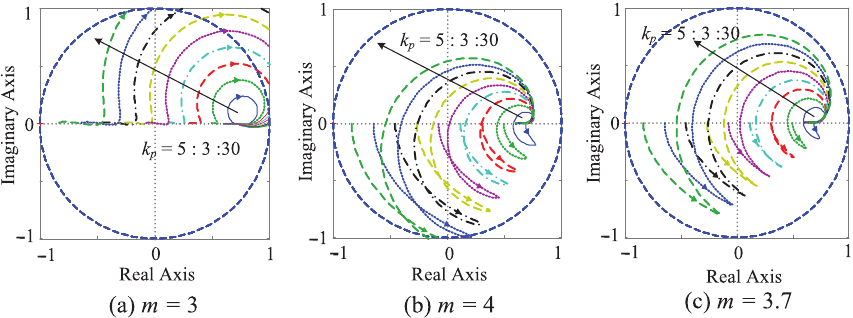
Figure 6. Trajectories of H ( e j ω T ) when ( a ) m = 3, ( b ) m = 4, and ( c ) m = 3.7, respectively.